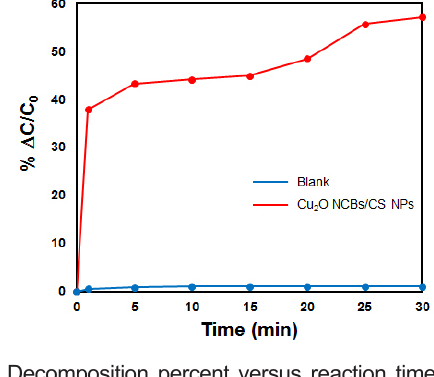
Fig. 8. Decomposition percent versus reaction time for the reduction of p -NP over (a) blank sample without catalyst and (b) using Cu O NCBs/CS NPs 2 composites catalyst,